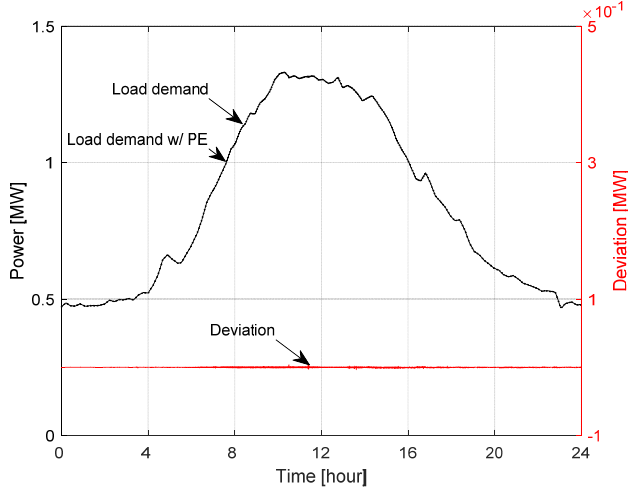
Figure 5. Served load demand comparison between two cases.